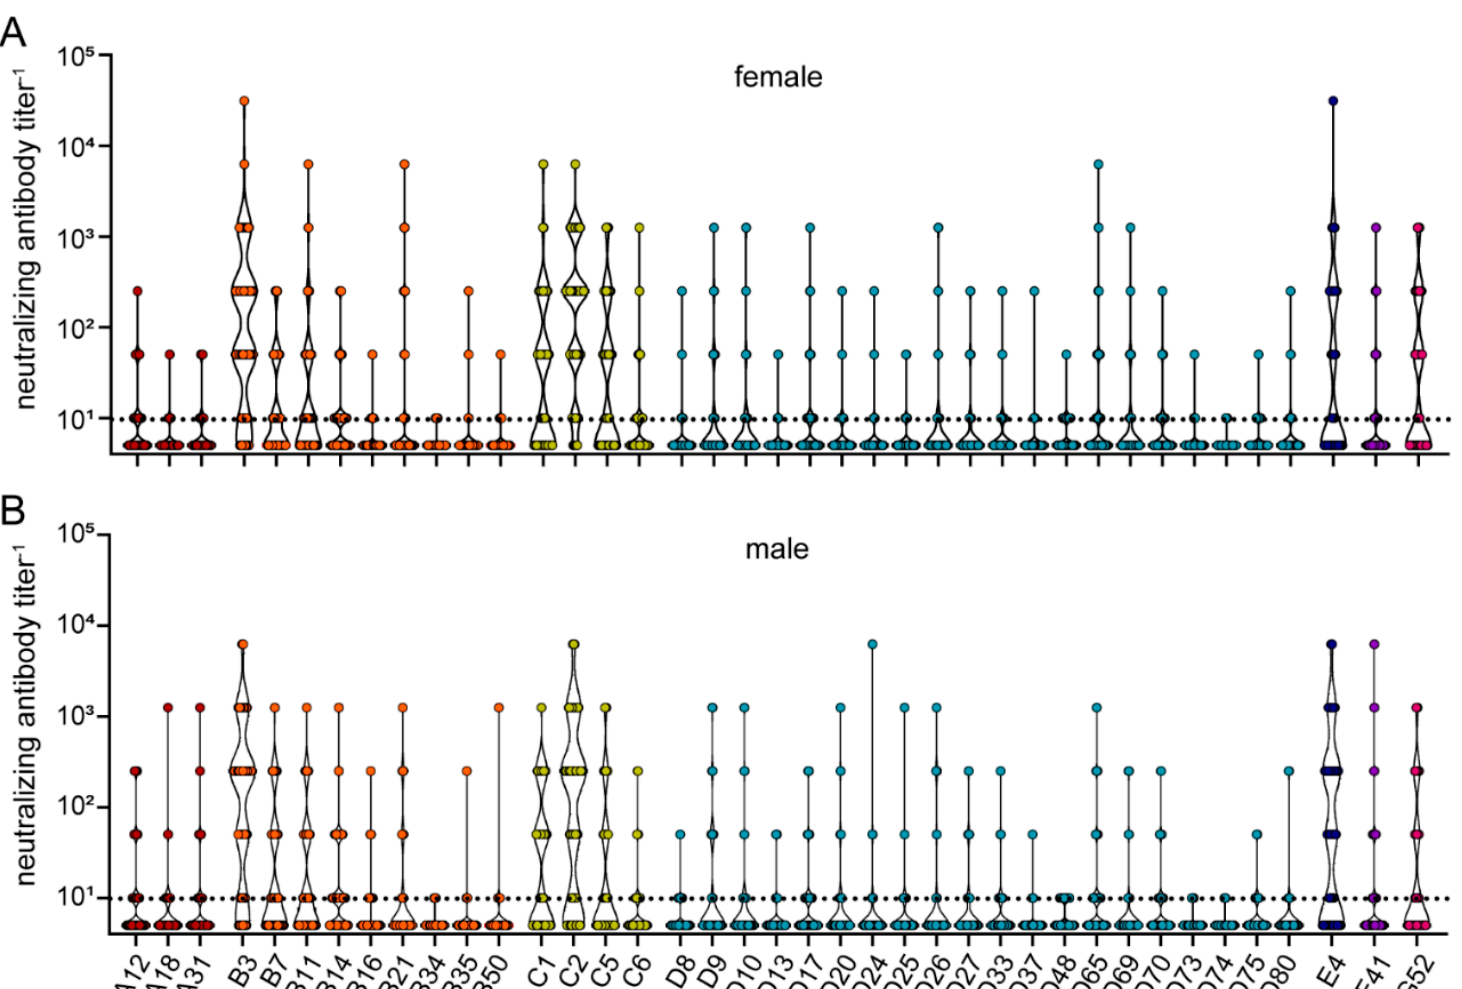
Figure 8. Neutralizing antibody data stratified by sex of serum donors. The data presented in Figure 5 were stratified by the sex of the serum donors, showing data from 107 female ( A ) and 102 male serum donors ( B ). Each dot represents an individual sample. No statistically significant differences in neutralizing antibody levels of female and male serum donors were found using Kruskal-Wallis one-way ANOVA on ranks and Dunn’s multiple comparisons test.